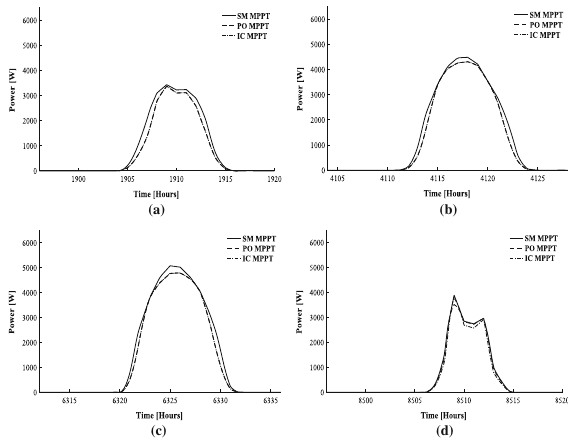
Fig. 7 Daily generated power using different MPPT techniques on the Mono-Si PV array SM55 for a March 21, b